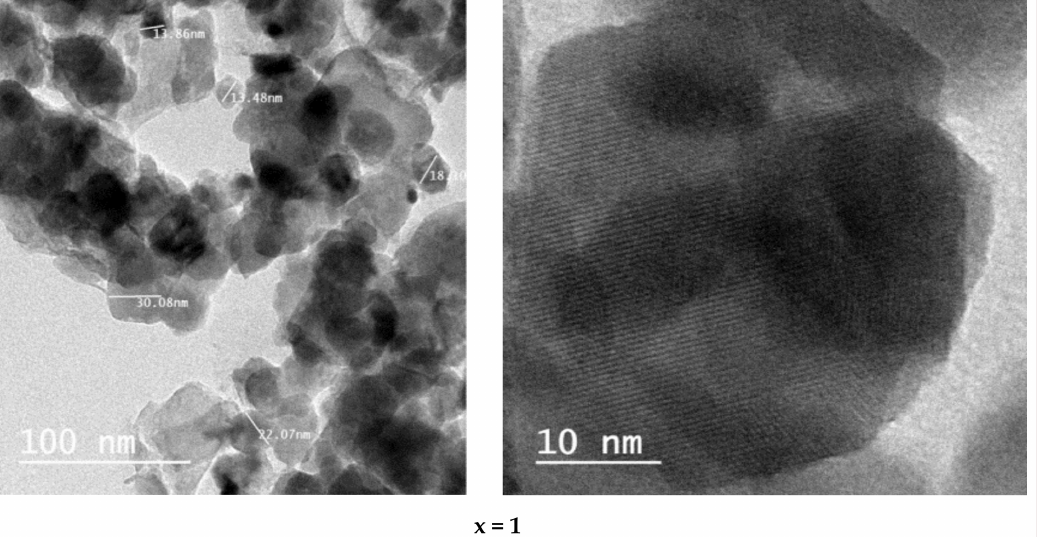
Figure 3. HRTEM images and the corresponding fringing spacing of Ni + 2 0.6, 0.8, and 1).